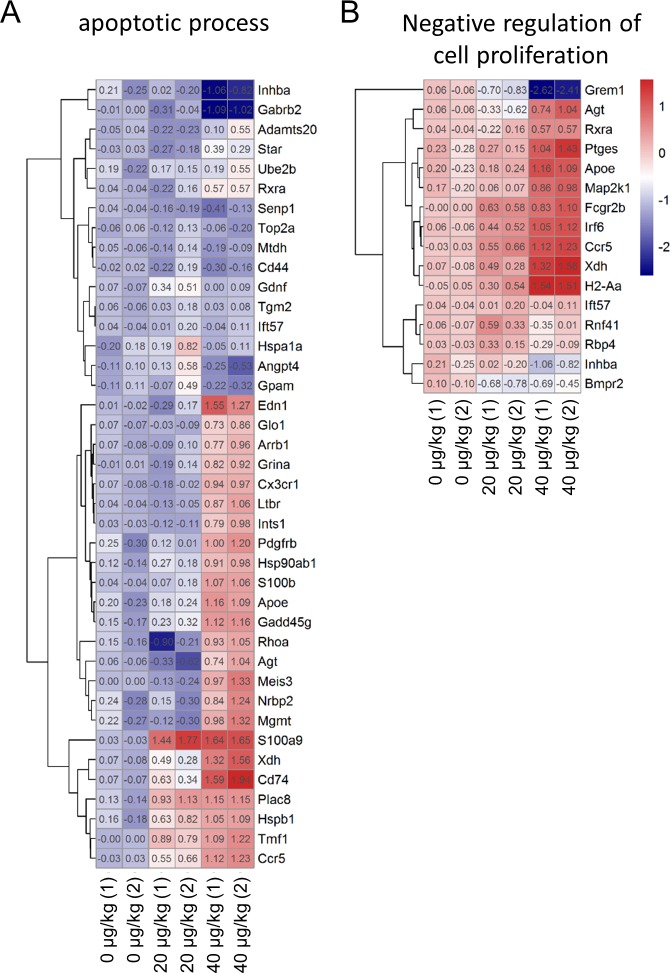
Heatmaps of DEGs.(A) apoptotic processes and (B) negative regulation of cell proliferation related genes expressions, via microarray, in control and DEHP-treatment groups.